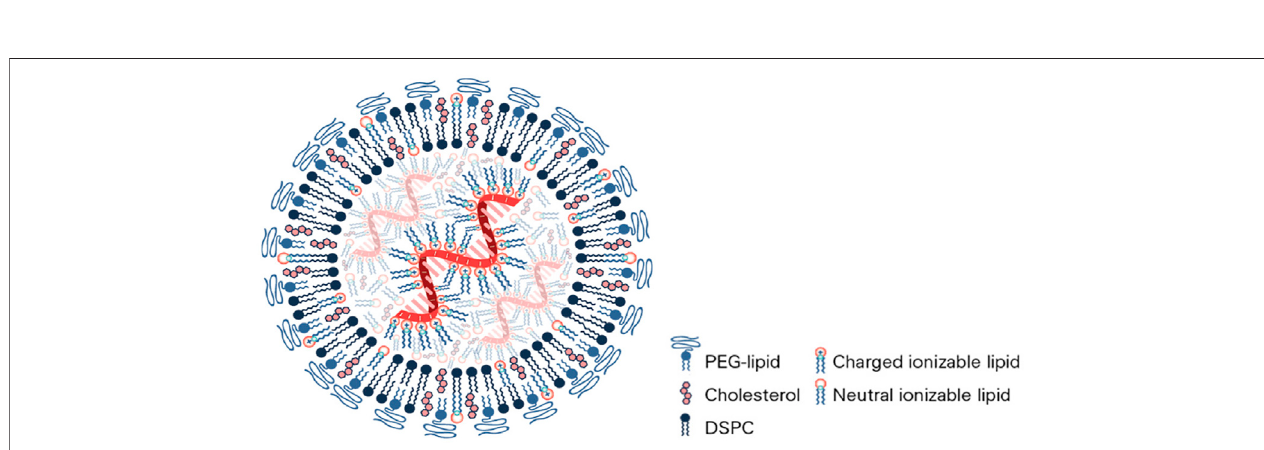
FIGURE4| BrushandmushroomconformationofPEGonananoparticlesurface.D:distancebetweentwograftingsites;L:thicknessofthegraftedPEG;R F :Flory radius. Figure from ref (Buschmann et al., 2021).